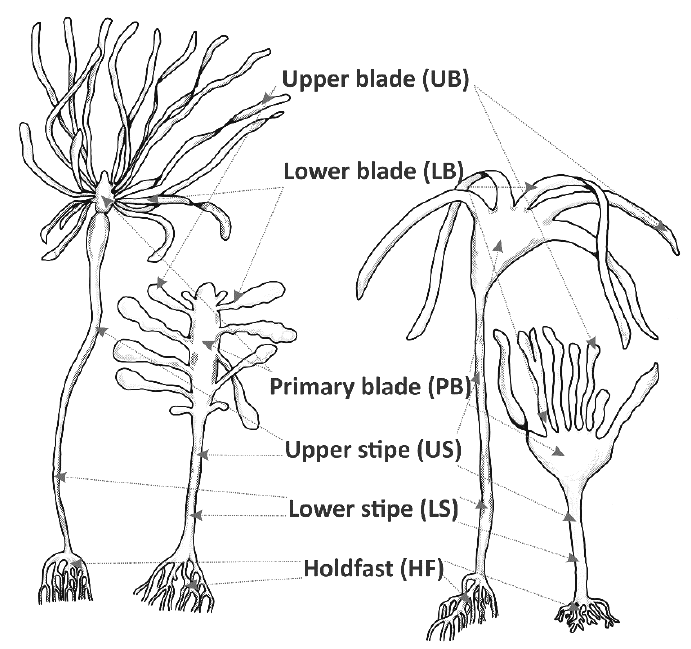
Figure 2. Schematic representation of adult and juvenile specimens of Ecklonia maxima and Laminaria pallida showing different parts of the thalli.